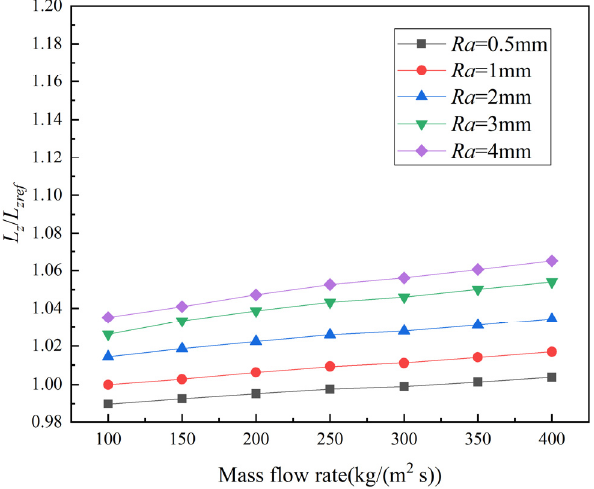
Figure 17. The ratios of the total length of PCHE with different curvature radii of inserted arc segments to the total length of Z-shaped PCHE at different mass flow rates.